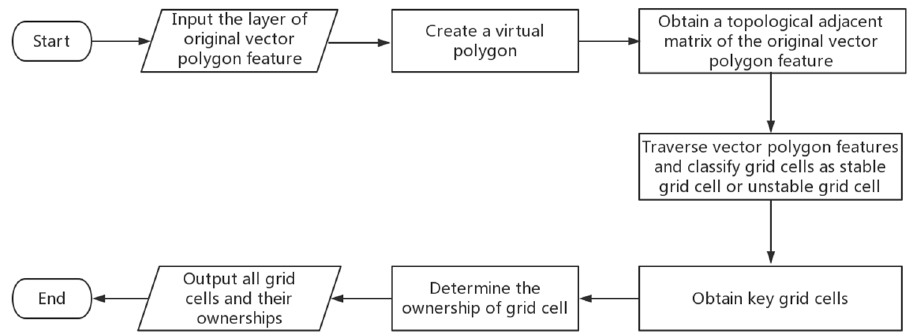
Figure 11. Initial gridding of polygon features.